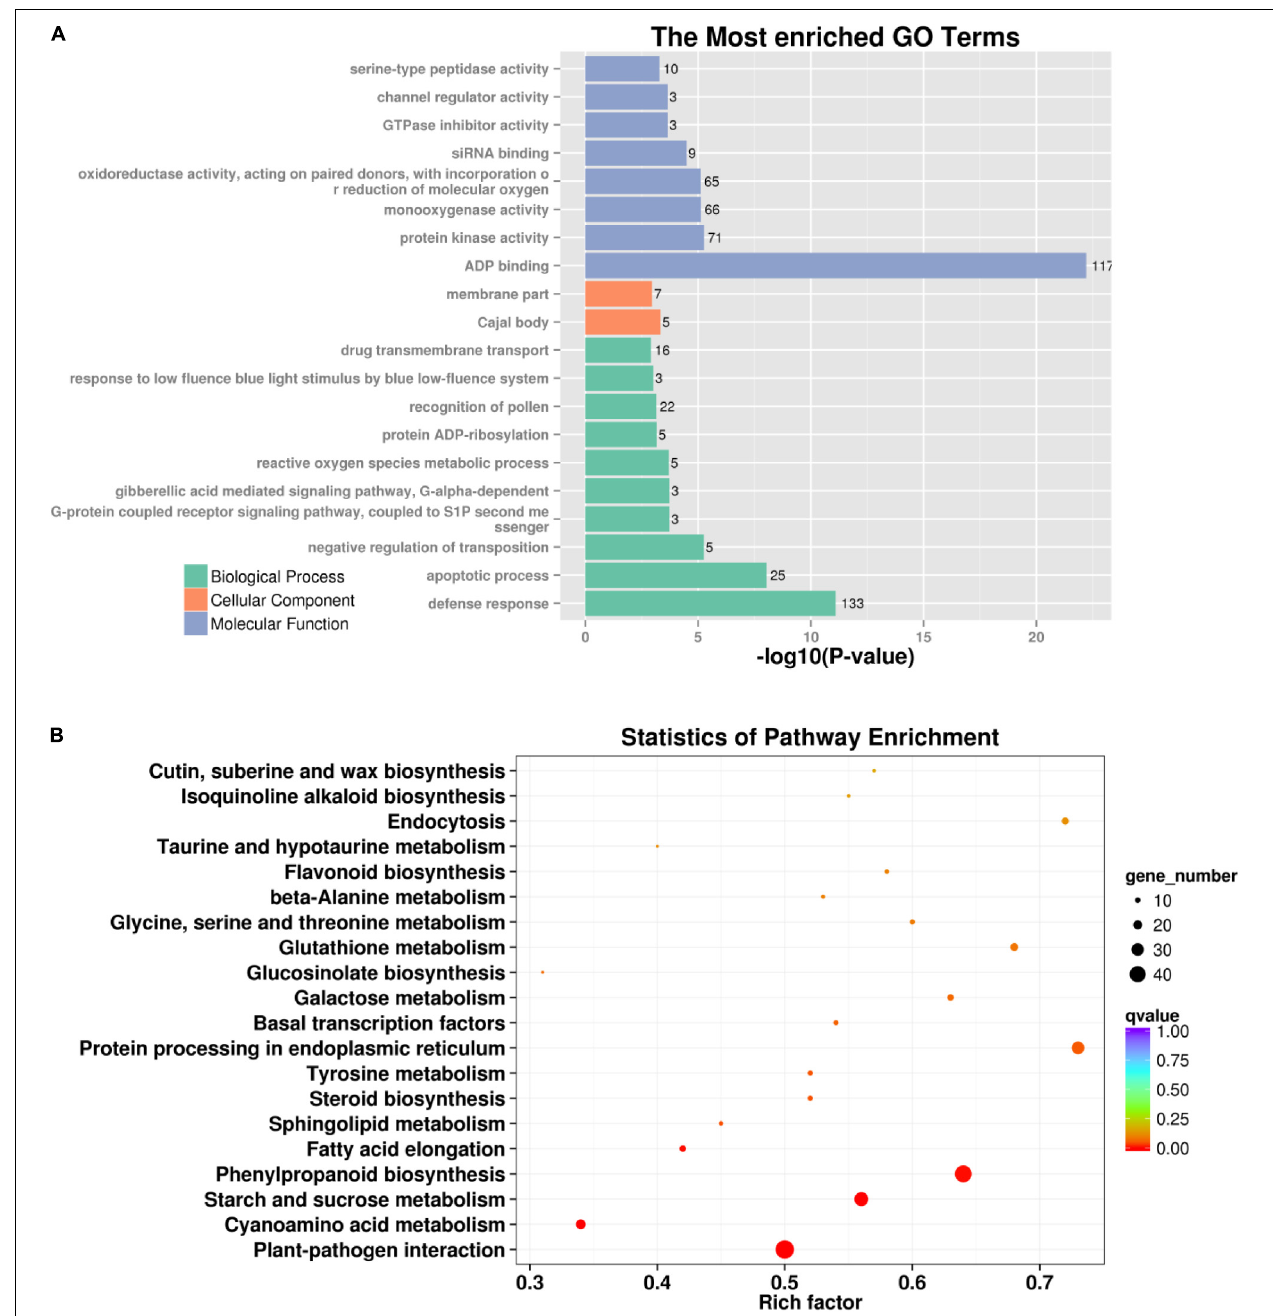
FIGURE 5 | GO and KEGG enrichment analysis of genes with functional variations. (A) Top 20 GO terms are enriched in genes with termination or frameshift variations. The significance of enriched terms was determined by REVIGO. (B) The most enriched KEGG pathways in genes with termination or frameshift variations. The rich factor represents the degree of mutated genes in a particular pathway. The number of enriched genes is indicated by the size of the circle, and the circle color reflects the range of the corrected p-